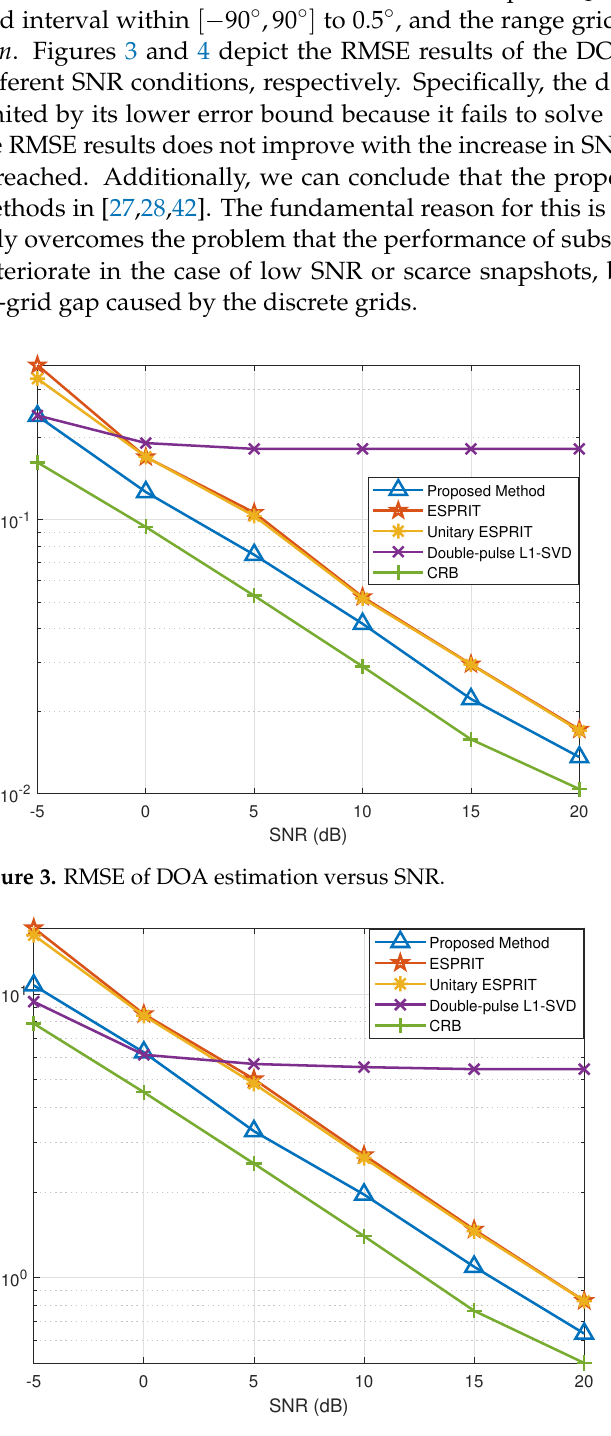
Figure 4. RMSE of range estimation versus